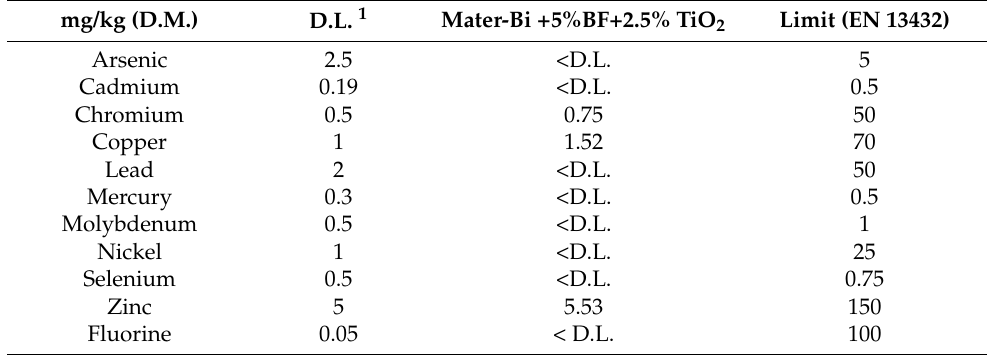
Table 17. Heavy metals and fluorine analysis results. mg/kg